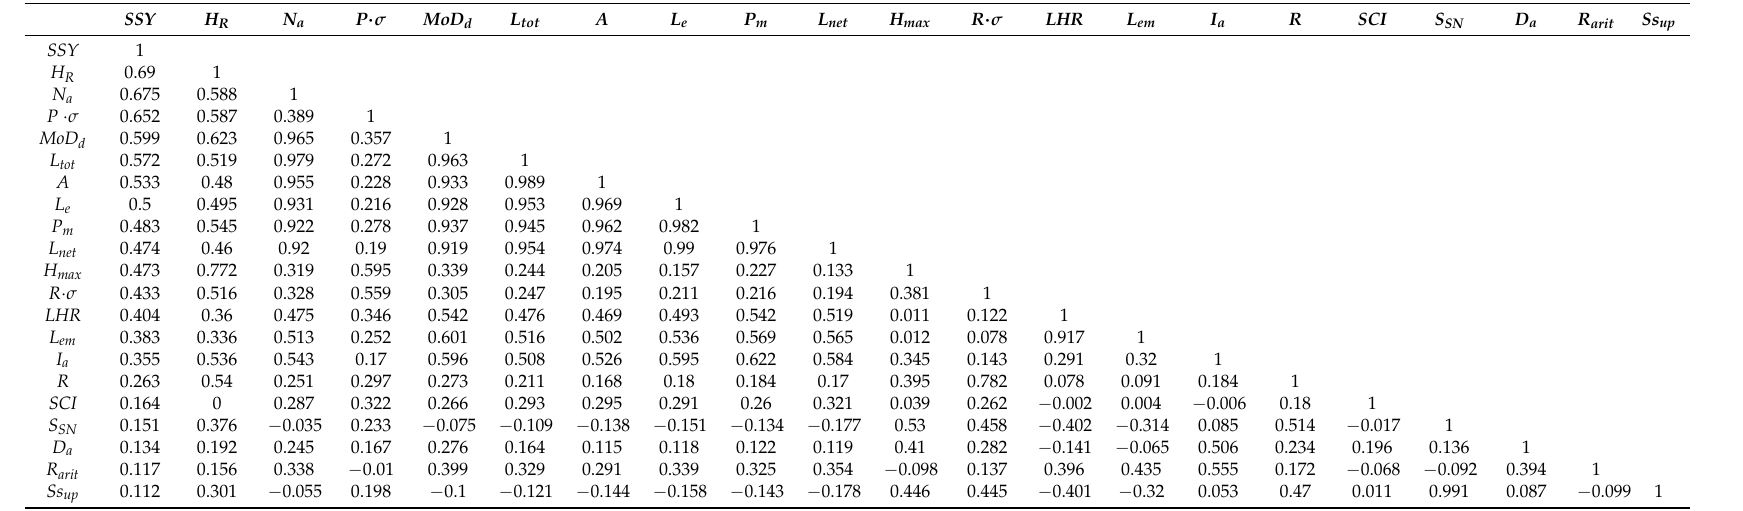
Table 3. Correlation matrix between SSY and most significantly correlated geomorphometric parameters ( r > 0.1). For symbols, see Appendix